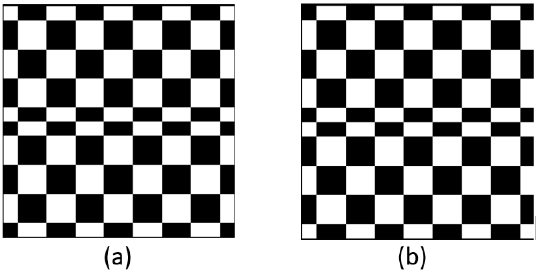
Figure 6. Original Hadamard mask and its inverse: ( a ) the original Hadamard mask and ( b ) the inverse of ( a ).